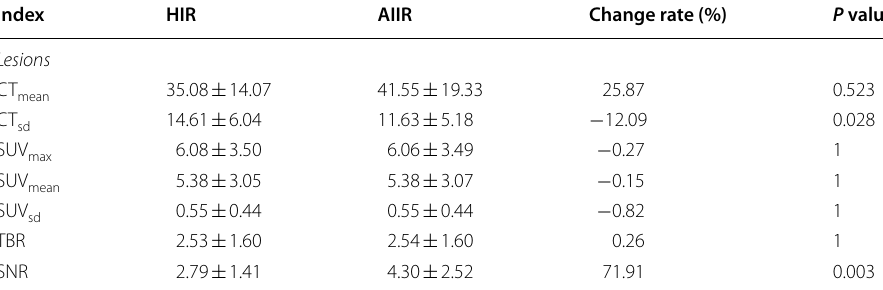
Table 3 Comparisons of objective measurements on lesions between the HIR and AIIR